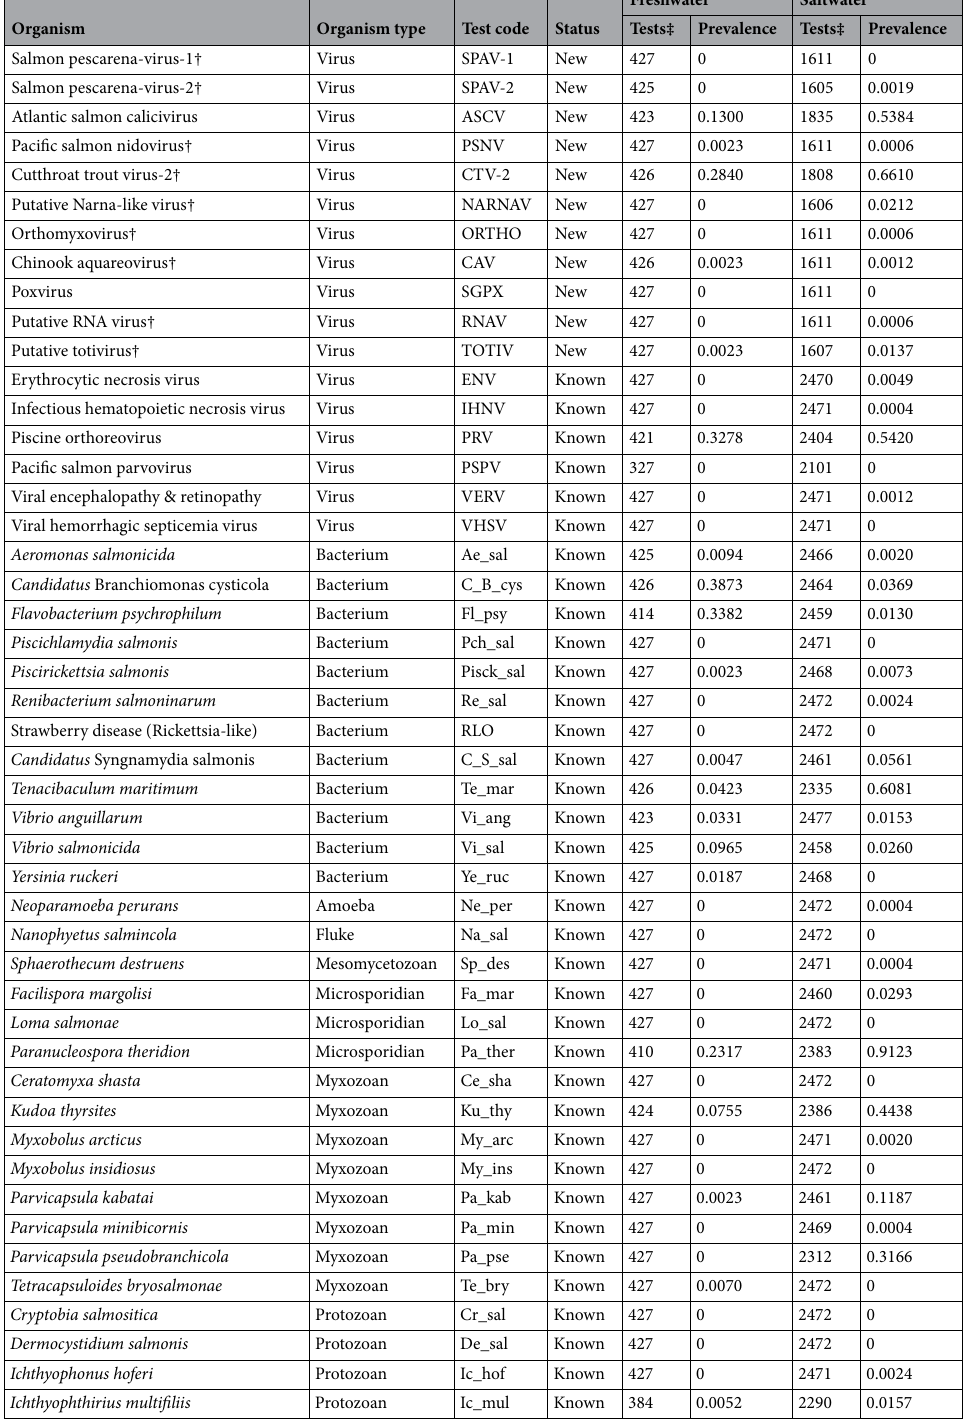
Table 3. Infective agents in mixed-tissue samples of farmed Atlantic salmon. †Indicates agents newly discovered or not known from salmon in BC 30,31 . ‡ successful tests only (i.e. those without evidence of control cross contamination, poor amplification curves, or low housekeeping gene